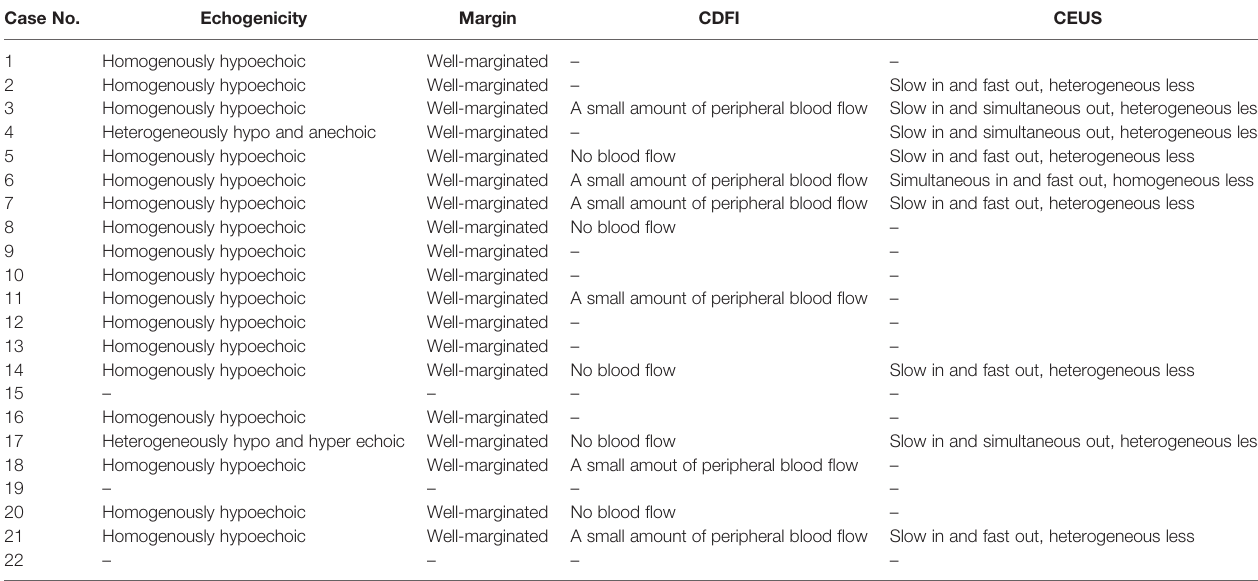
TABLE 2 | US characteristics of primary tumor.